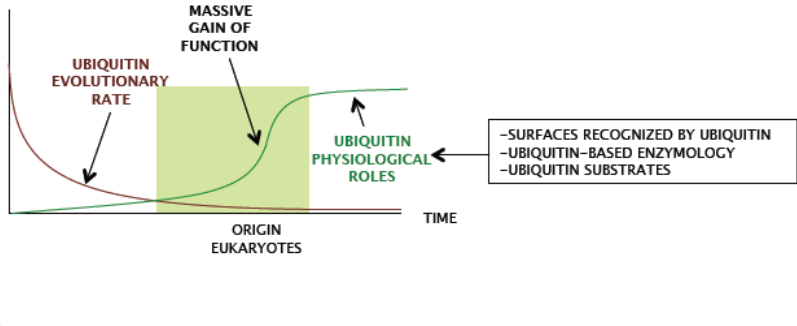
in eukaryotes. Figure 4. Hypothesis of a massive gain of function of ubiquitin in early eukaryotes. A schematic representation of the hypothetical behavior of ubiquitin evolutionary rate and ubiquitin physiological roles during time is shown. Ubiquitin evolved from ancestral forms of beta-grasp folded proteins (see also Figure 1), and its evolutionary rate decreased to a minimum, coincident with the origin of eukaryotes. Concomitantly, ubiquitin physiological roles increased massively, which resulted in a dramatic increase of ubiquitin signaling related genes in eukaryotic